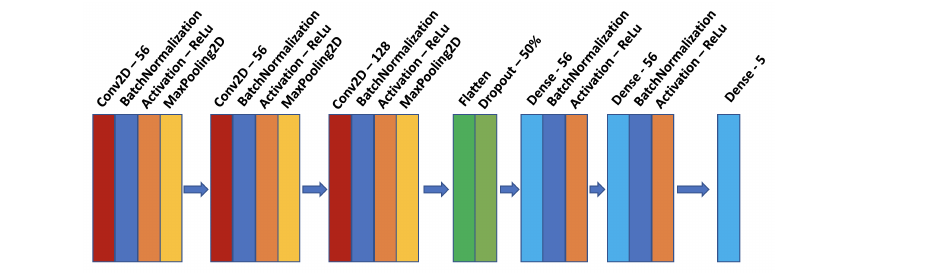
Figure 4. Schematic view of the network architecture that has been adopted. The numbers beside "Conv 2D" represent the number of filters. The numbers beside "Dense" represent the number of neurons of that layer.